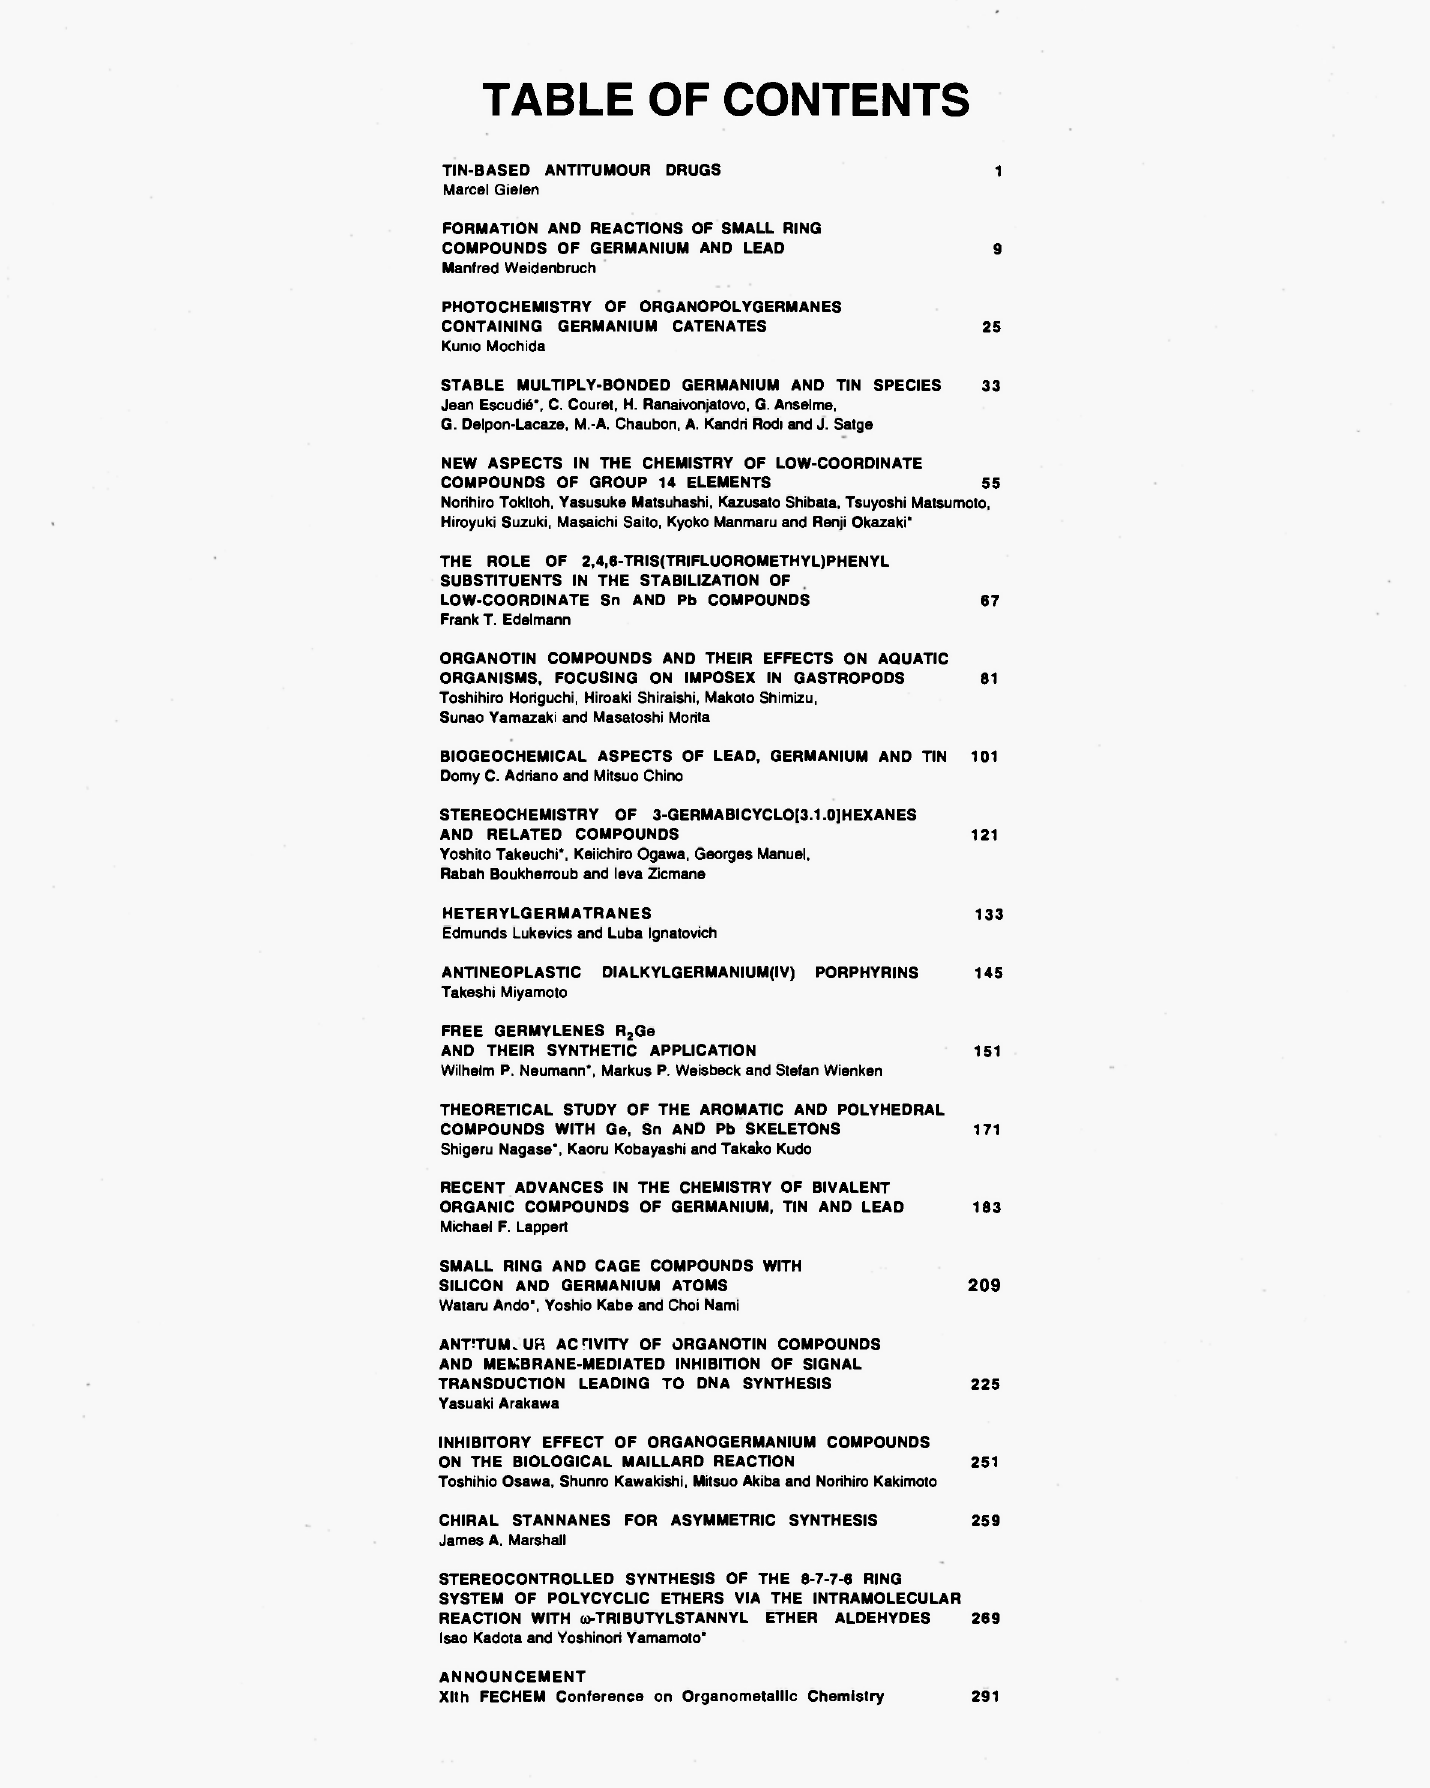
FORMATION AND REACTIONS OF SMALL RING COMPOUNDS OF GERMANIUM AND